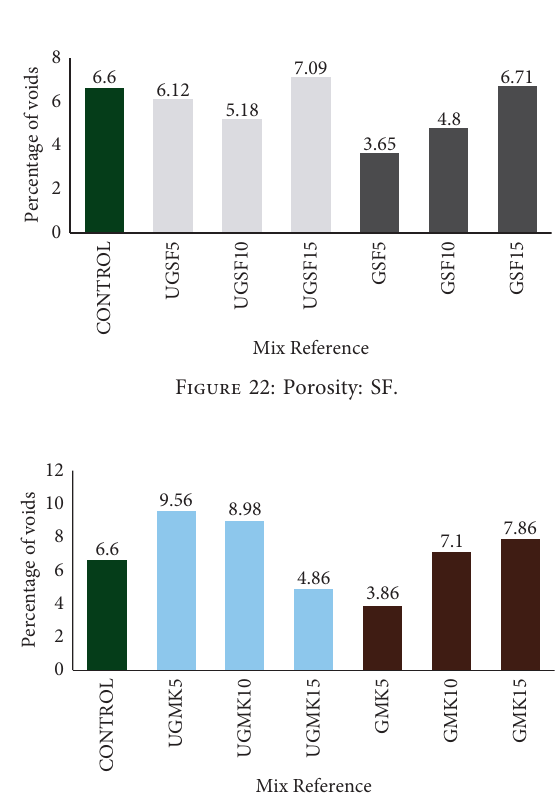
Figure 23: Porosity: